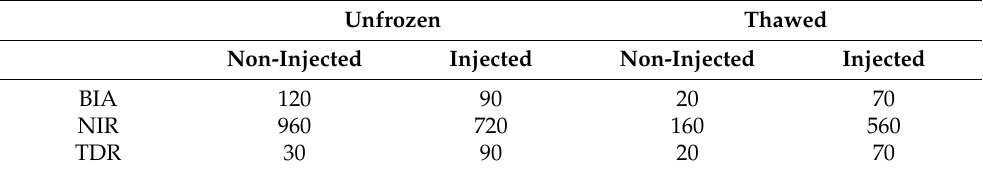
Table 1. Number of scans measured with BIA, NIR and RFQ-Scan ® equipment. Unfrozen Thawed